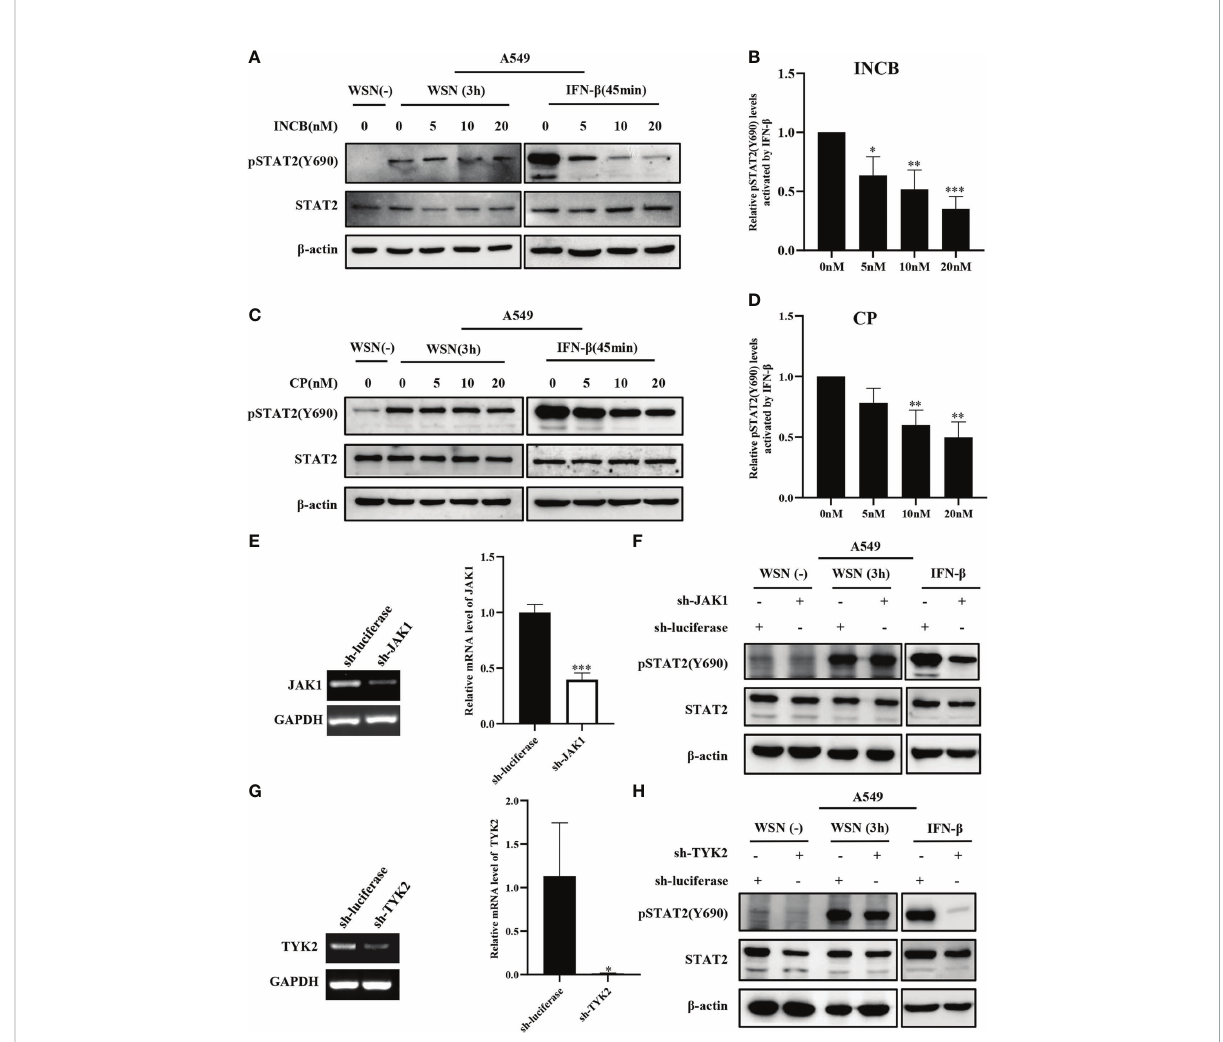
FIGURE 3 Inhibition and silence of JAKs have little effect on IAV-induced early phosphorylation of STAT2 at Y690. (A, C) A549 cells were pretreated with INCB018424 (INCB) (A) and CP-690550 (CP) (C) at different concentrations for 20 min, respectively, followed by WSN infection for 3 h or IFN- b (0.1 m g/mL) stimulation for 45 min. Western blotting analysis of pSTAT2 levels revealed representative blots from three independent experiments. (B, D) The level of pSTAT2 in (A) , (C) was quanti fi ed by densitometry and normalized to STAT2 levels. The data are shown as the mean ± SD from three independent experiments. *p < 0.05; **p < 0.01; ***p < 0.001. (E, G) The interference ef fi ciencies in JAK1- (E) and Tyk2- (G) ablated and control (luciferase) A549 cells were detected by RT-PCR (Left) and RT-qPCR (Right). Error bars represent the mean ± SD from three independent experiments. *p < 0.05; **p < 0.01; ***p < 0.001. (F, H) A549 cells as described in (E, G) were infected with WSN for 3 h or stimulated with IFN- b (0.1 m g/mL) for 45 min, respectively. The expression levels of speci fi c proteins were detected by Western blotting. The data in the fi gures are representative images of three